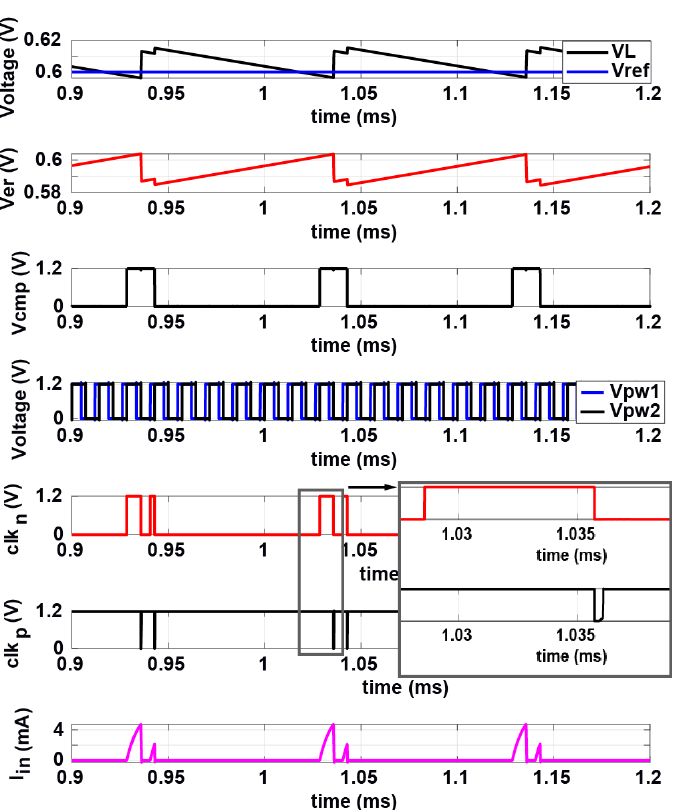
Figure 7. Steady state response of the SI boost regulator with PWM and PSM feedback loops at steady state at V L = 0.6 V, I L = 10 µ A.